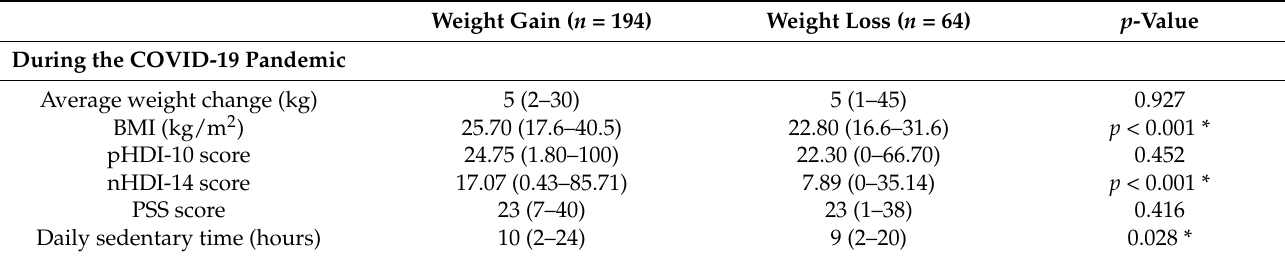
Table 2. Comparison of mean weight changes; BMI; pHDI-10, nHDI-14, and PSS scores; and daily sedentary time of individuals who lost or gained weight during the COVID-19 pandemic.